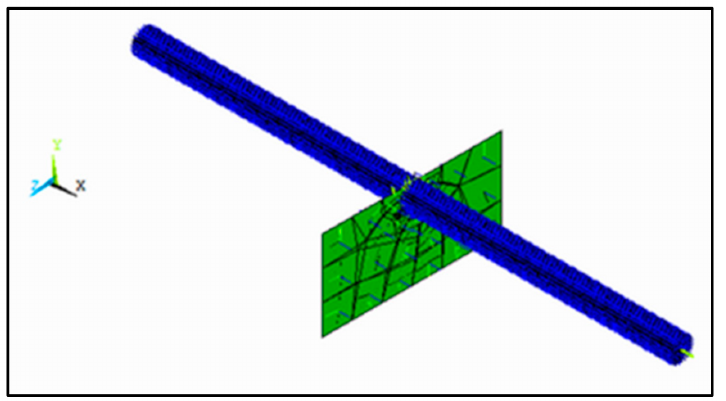
Figure 4. Contact pair